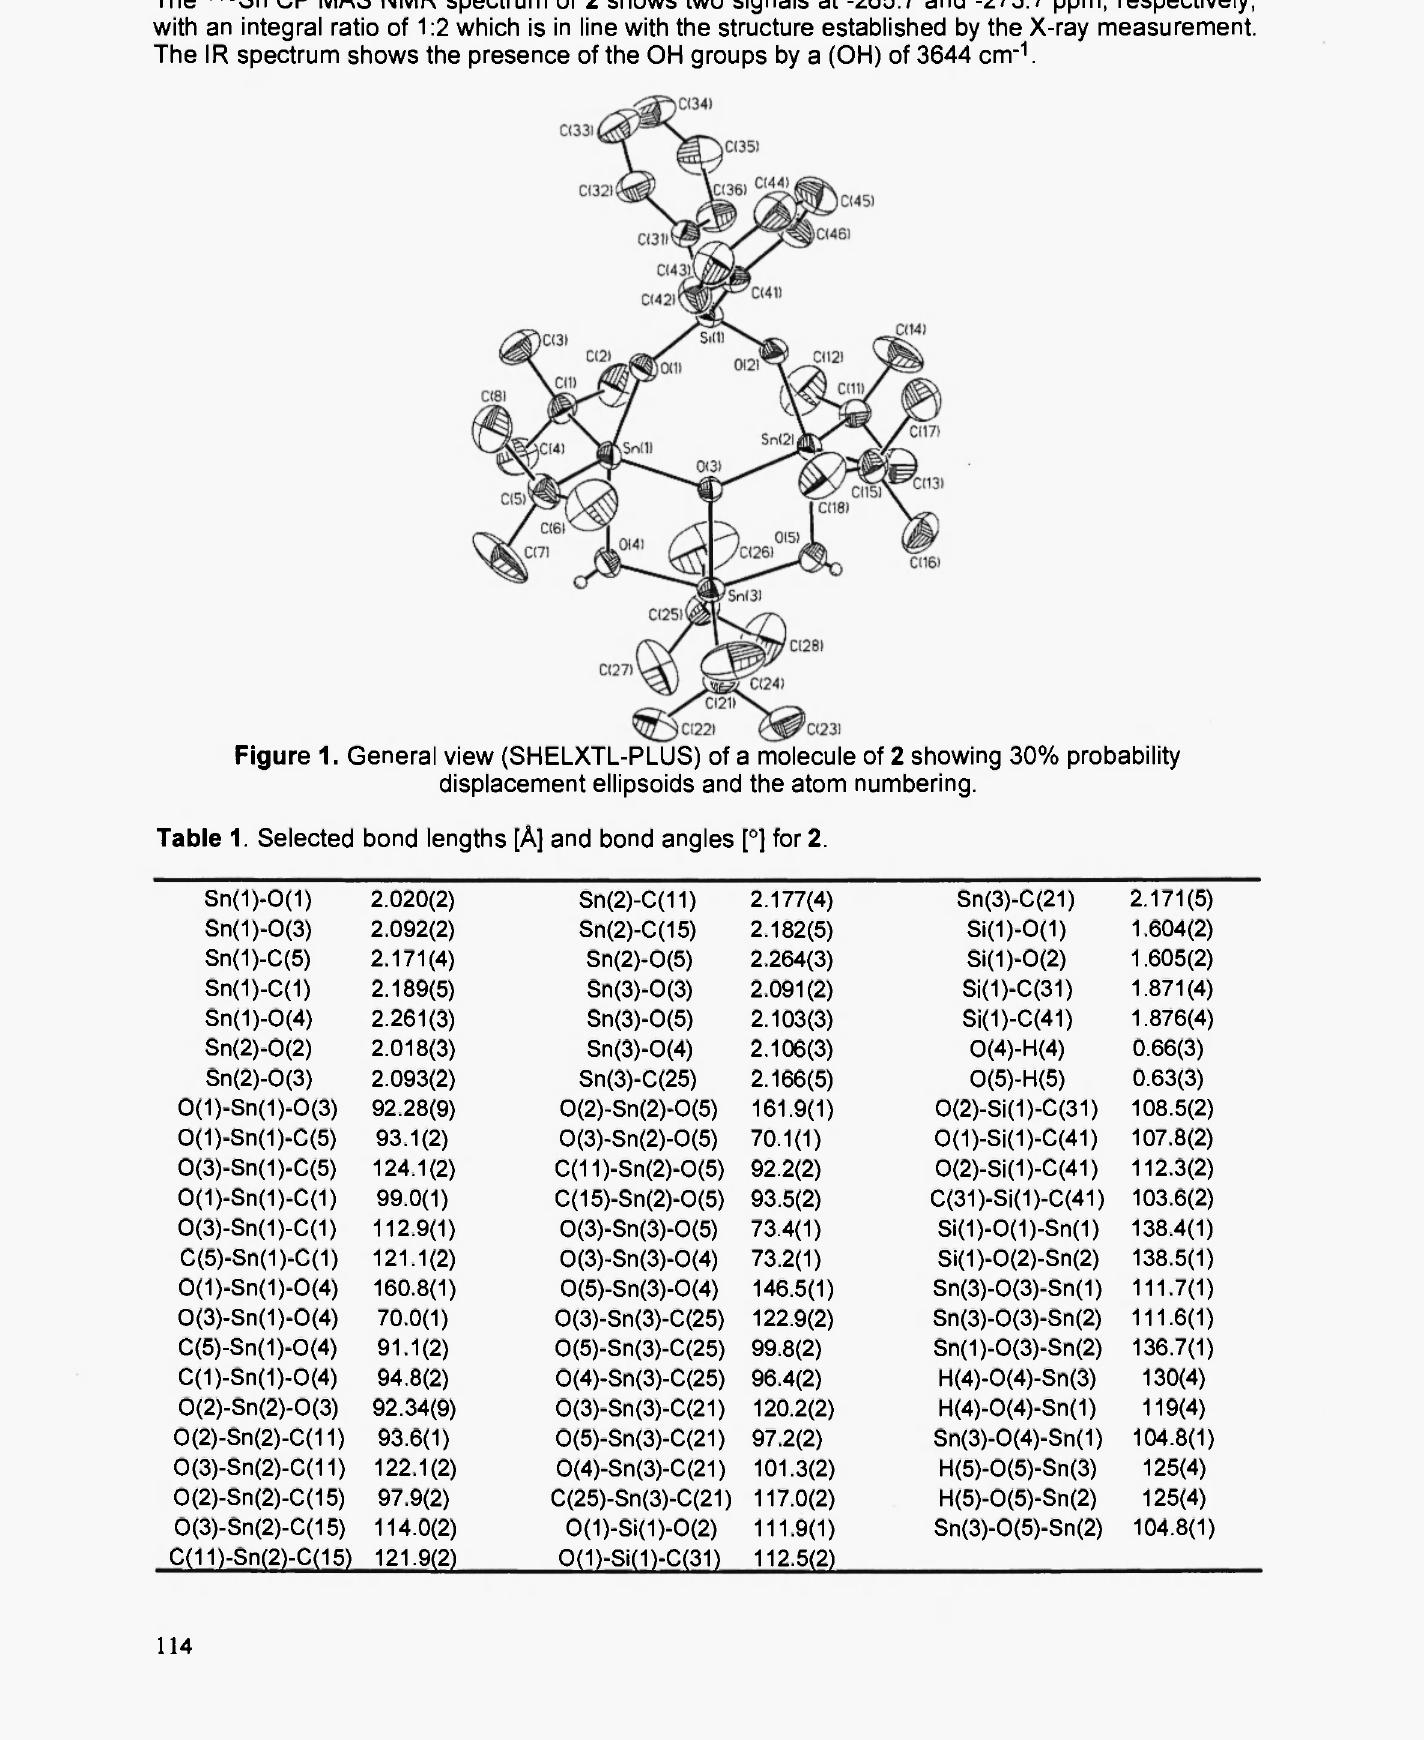
Figure 1. General view (SHELXTL-PLUS) of a molecule of 2 showing 30% probability displacement ellipsoids and the atom numbering. Table 1. Selected bond lengths [A] and bond angles [°] for